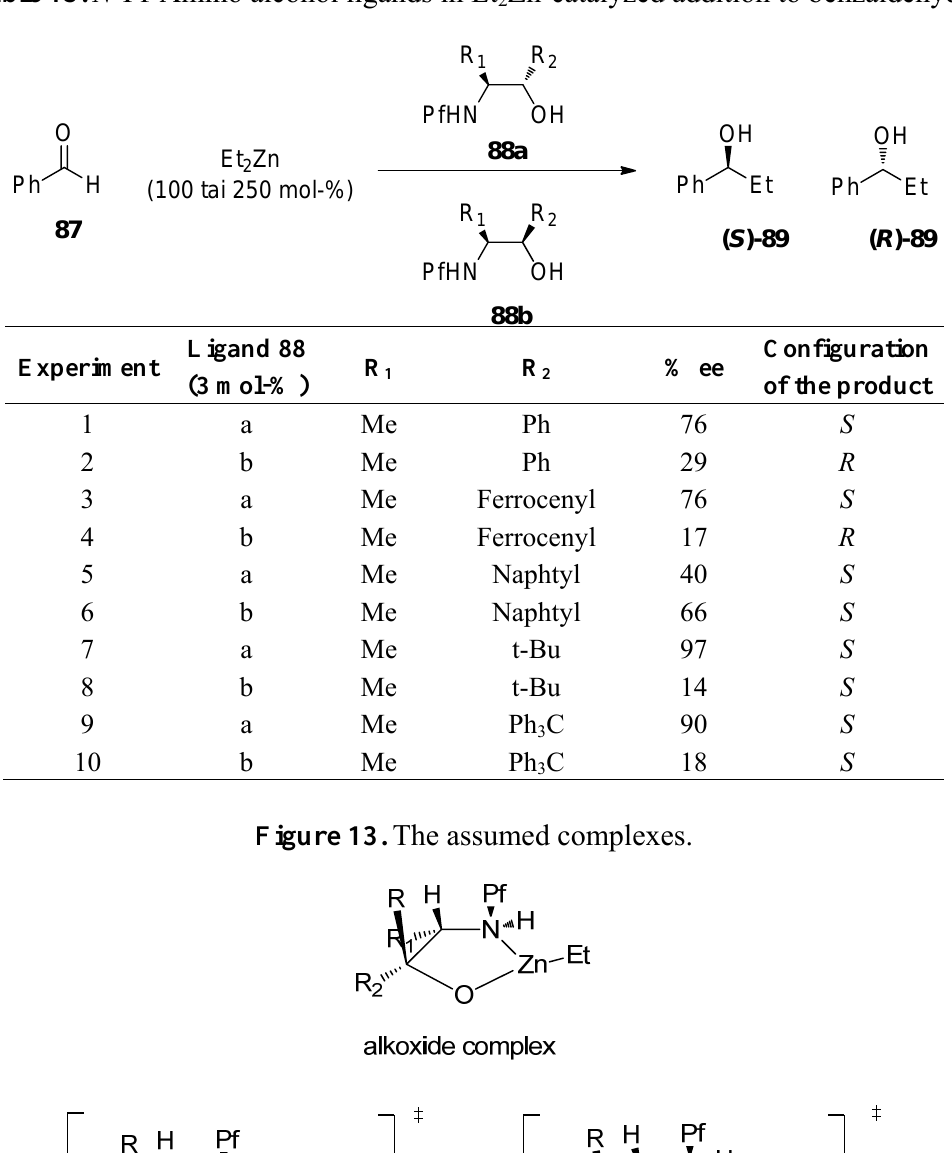
Table 13. N -Pf-Amino alcohol ligands in Et